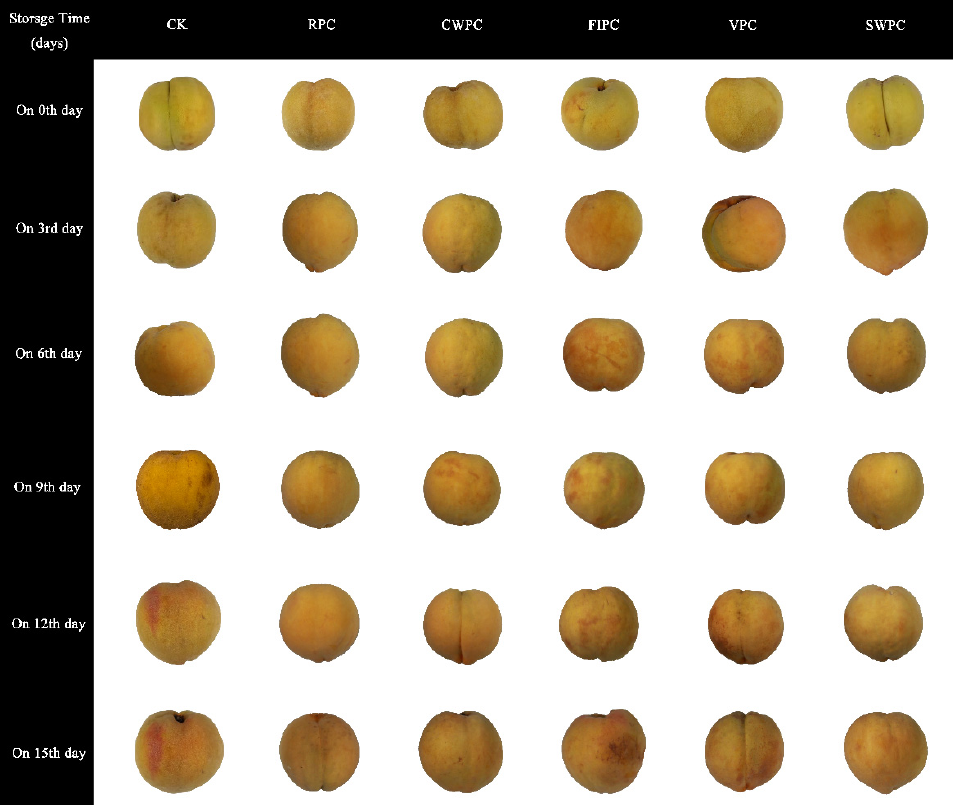
Figure 2. Appearance changes in yellow peaches with different precooling methods during cold storage. The abbreviations CK, RPC, CWPC, SWPC, FIPC, and VPC in the figure correspond to control group, refrigerator precooling, cold-water precooling, strong-wind precooling, fluidized-ice precooling, and vacuum precooling, respectively.